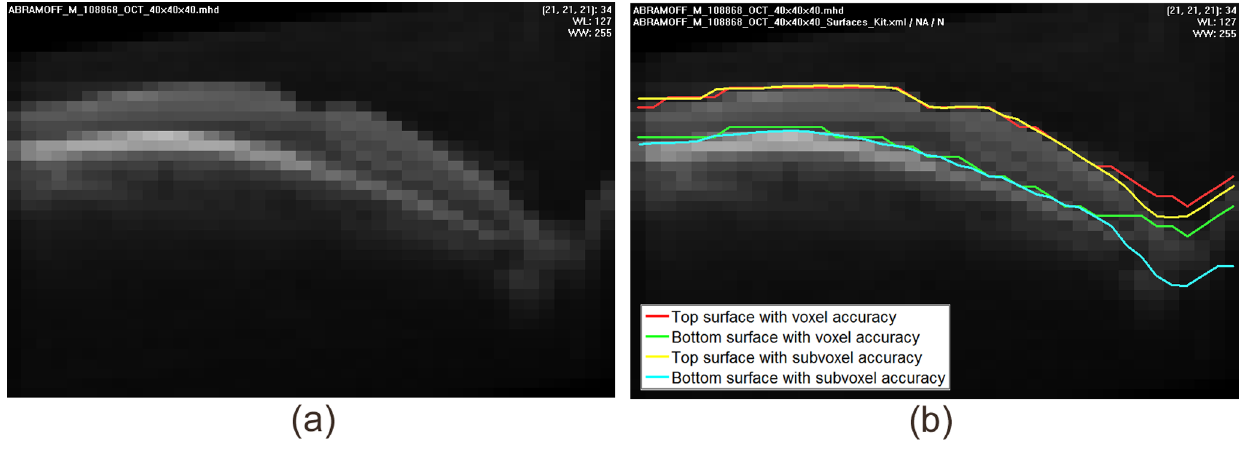
Figure 10. One B-scan of the down-sampled OCT volume. (a) One B-scan; (b) Two corresponding surfaces were identified by both conventional graph search and non-Euclidean graph search.